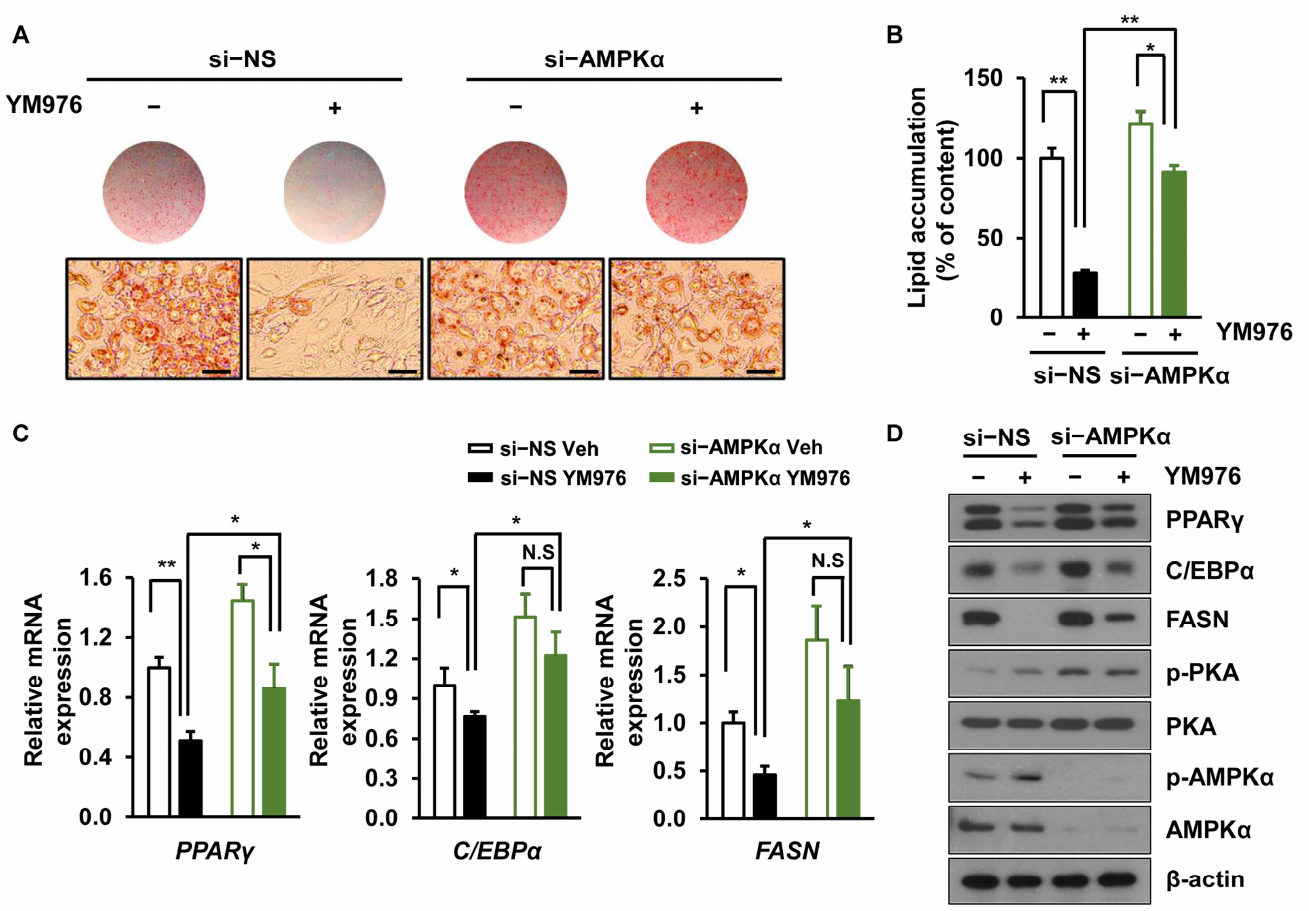
Figure 4. AMPK α depletion attenuates the inhibitory effect of YM976 on adipocyte differentiation. Cells were transfected with si-NS or si-AMPK α and then treated with Veh or 10 µ M YM976. ( A ) Cells were stained with Oil Red O and observed with microscopy. Scale bar = 100 µ m. ( B ) Quantification of Oil Red O staining by spectrophotometry. ( C ) The mRNA expression levels of PPAR γ , C/EBP α , and FASN were examined by qRT-PCR. ( D ) Expression levels of indicated protein were assessed by immunoblotting. In ( B , C ), n = 3 per group. In ( A , D ), images and blots are representative of three independent experiments. Values indicate mean ± SD. * p < 0.05; ** p < 0.01. N.S., not significant. Data were assessed by one-way ANOVA with Tukey’s post hoc test.